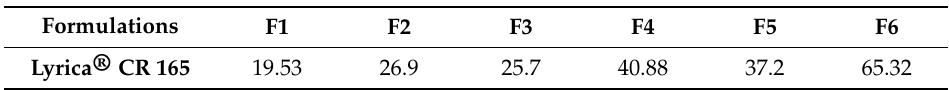
Table 4. Comparison of prepared formulations with commercialized products using similarity factor ( f 2